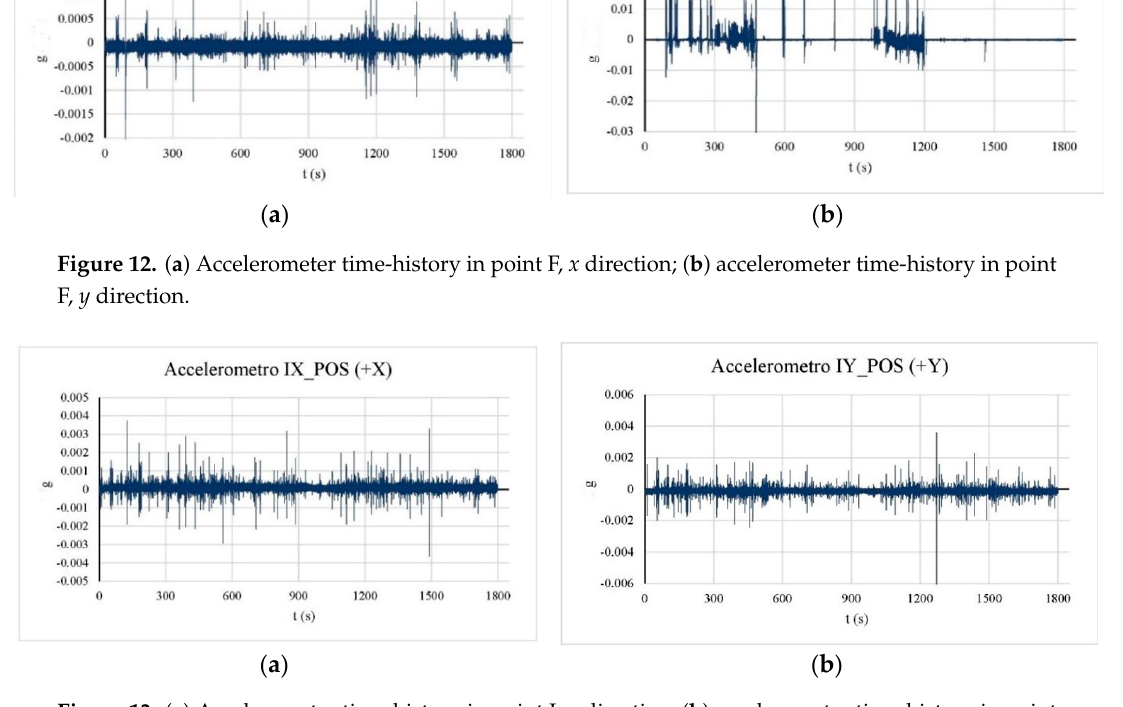
Figure 13. ( a ) Accelerometer time-history in point I, x direction; ( b ) accelerometer time-history in point F, y